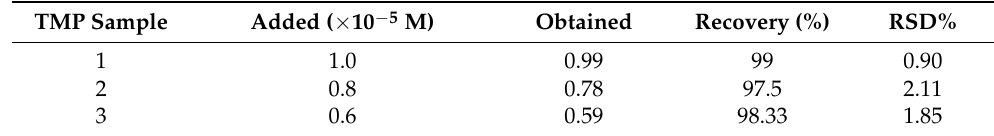
Table 3. Urine sample analysis of